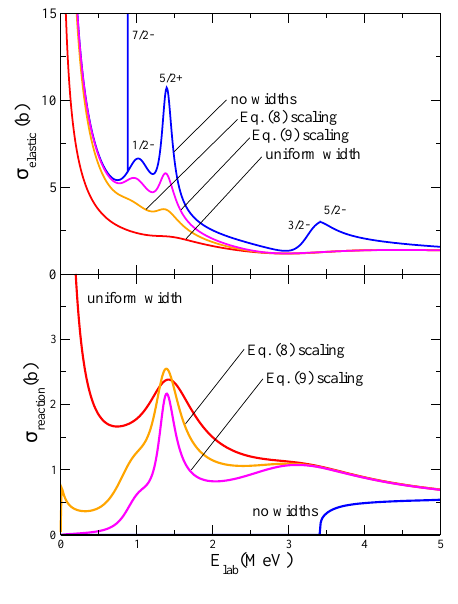
Figure 2. MCAS n + 8 Be elastic cross sections (upper panel) and reaction cross sections (lower panel) for Eq. (9) and (10).